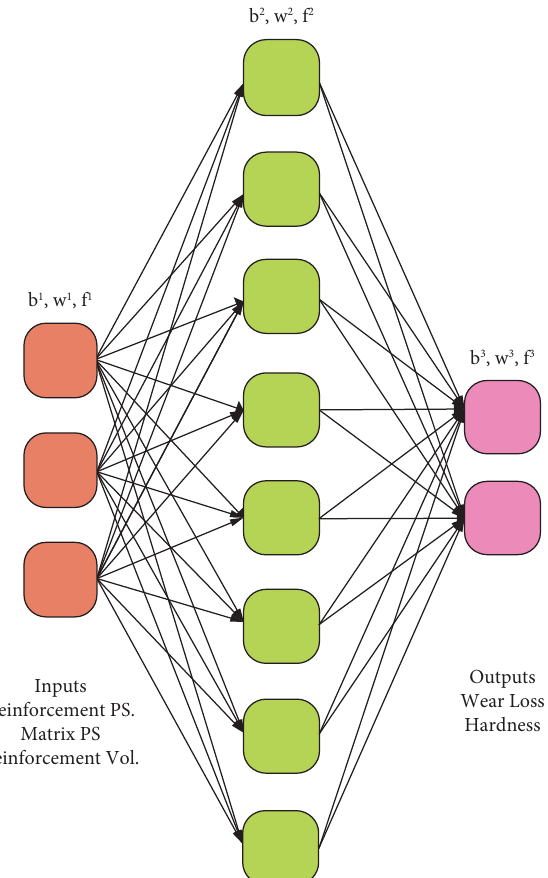
Figure 3: Framework of the functional